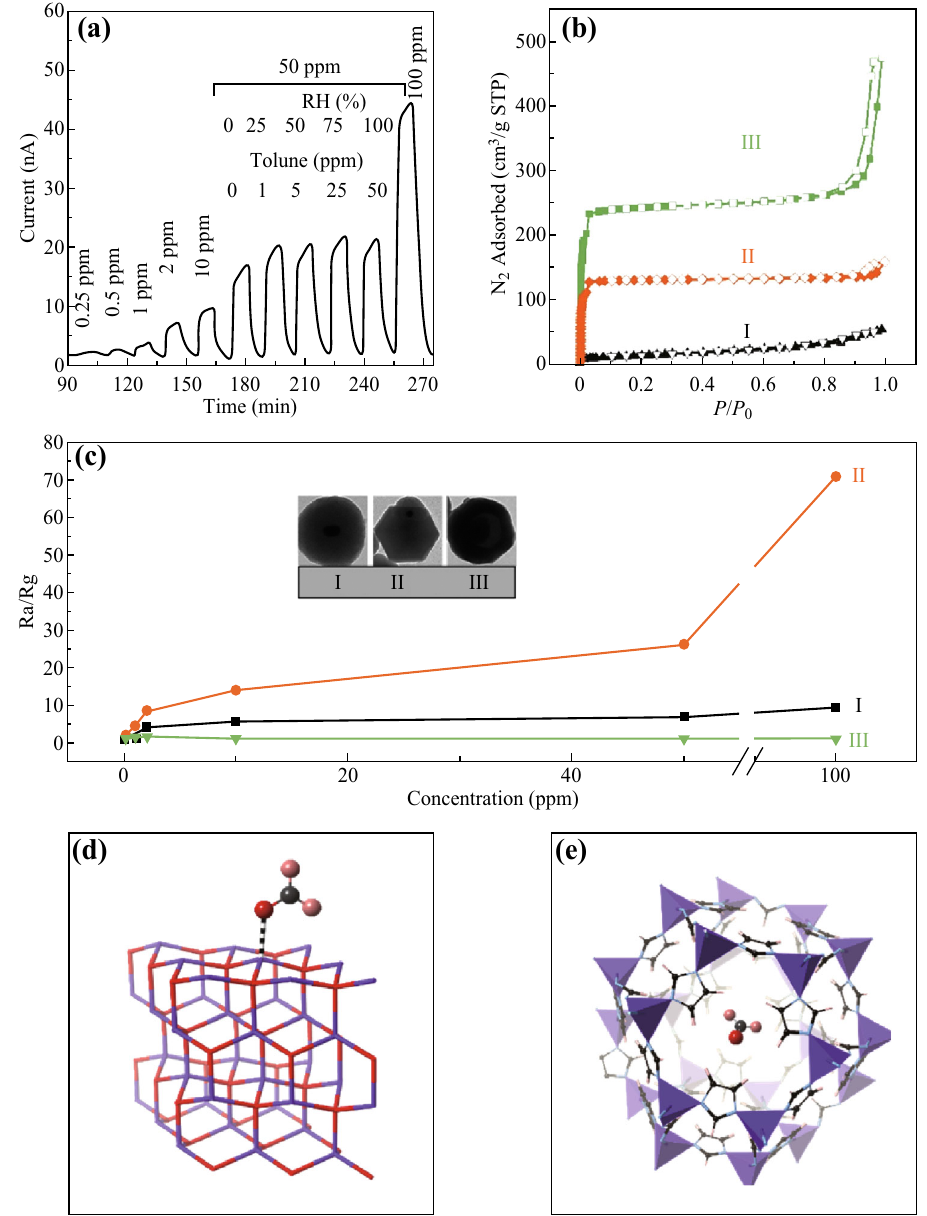
Fig. 5 a Dynamic response-recovery of Au@ZnO@ZIF-8 (Sample II) to HCHO with concentrations from 0.25 to 100 ppm, b Nitrogen sorption isotherms for Samples I, II, and III, solid symbols represent adsorption branches, and blank symbols represent desorption branches. Sample I displays a type II isotherm, indicating its non-porosity, while with ZIF-8 coating, both Samples II and III display type I isotherm, suggesting their microporosity [28]. c Plots of sensor responses to HCHO concentration of different samples, inset is the typical TEM images of different samples. Optimized structures of one formaldehyde molecule adsorbed d on the surface of ZnO and e inside ZIF-8. A chemical bond is formed between the HCHO and Zn. In the case of ZIF-8, the HCHO forms a physisorption with the organic linker. Oxygen is in red, zinc in purple, carbon in gray, nitrogen in blue, and hydrogen in